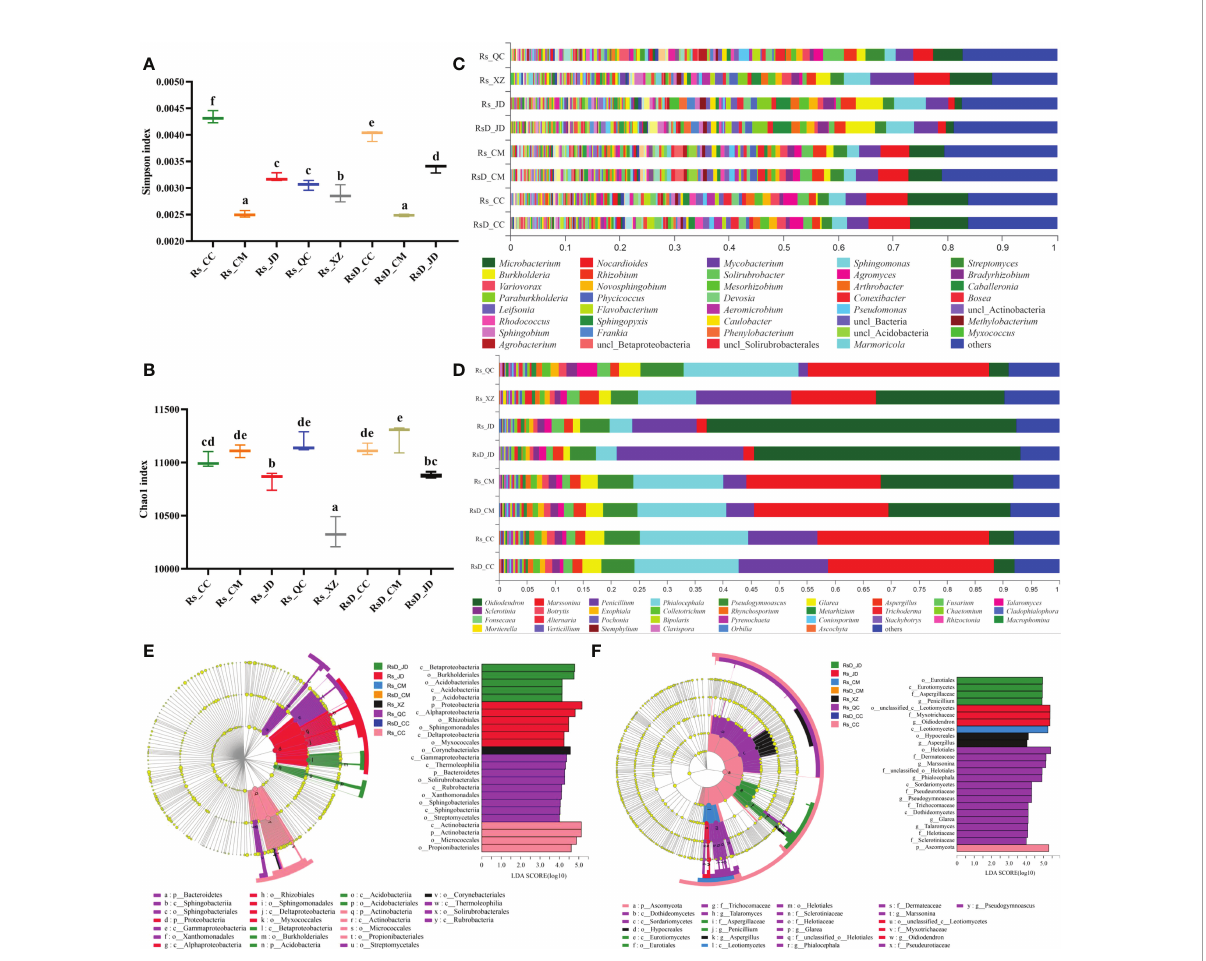
FIGURE 1 Rhizosphere microorganism composition of Crocus sativus from different origins. Boxplot of alpha-diversity indices: (A) Shannon index; (B) Chao1 index (group signi fi cance is indicated by letters; non-identical letters indicate p < 0.05). (C) Relative abundances of bacterial genera in samples. (D) Relative abundances of fungal genera in samples. (E) Cladogram generated from LEfSe analysis showing the most differentially abundant bacterial taxa enriched in rhizosphere with LDA scores (LDA score > 4 are shown). (F) Cladogram generated from LEfSe analysis showing the most differentially abundant fungal taxa enriched in rhizosphere with LDA scores (LDA score > 4 are